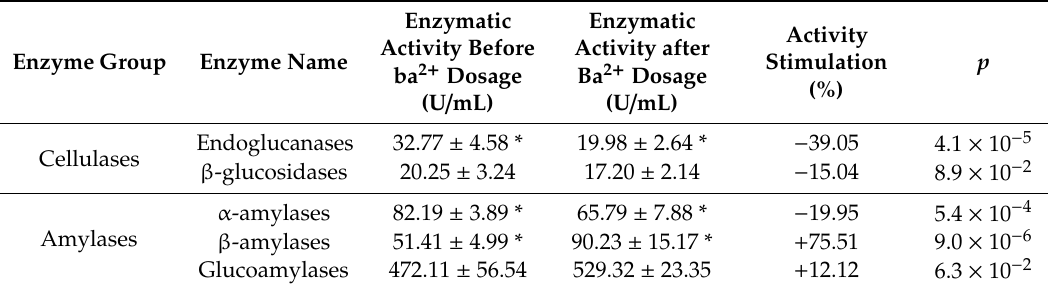
Table 7. Activity values and significance for the di ff erent studied enzyme